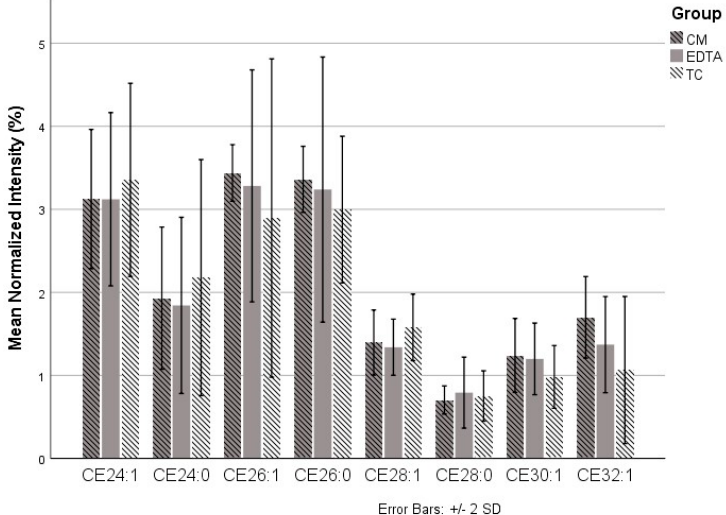
Figure 4. Comparison of the three techniques for the cholesteryl esters (CEs) that were only detected in HMGECs. Chloroform–methanol (CM), ethylenediaminetetraacetic acid (EDTA), trypsin-containing (TC) (trypsin–EDTA) .